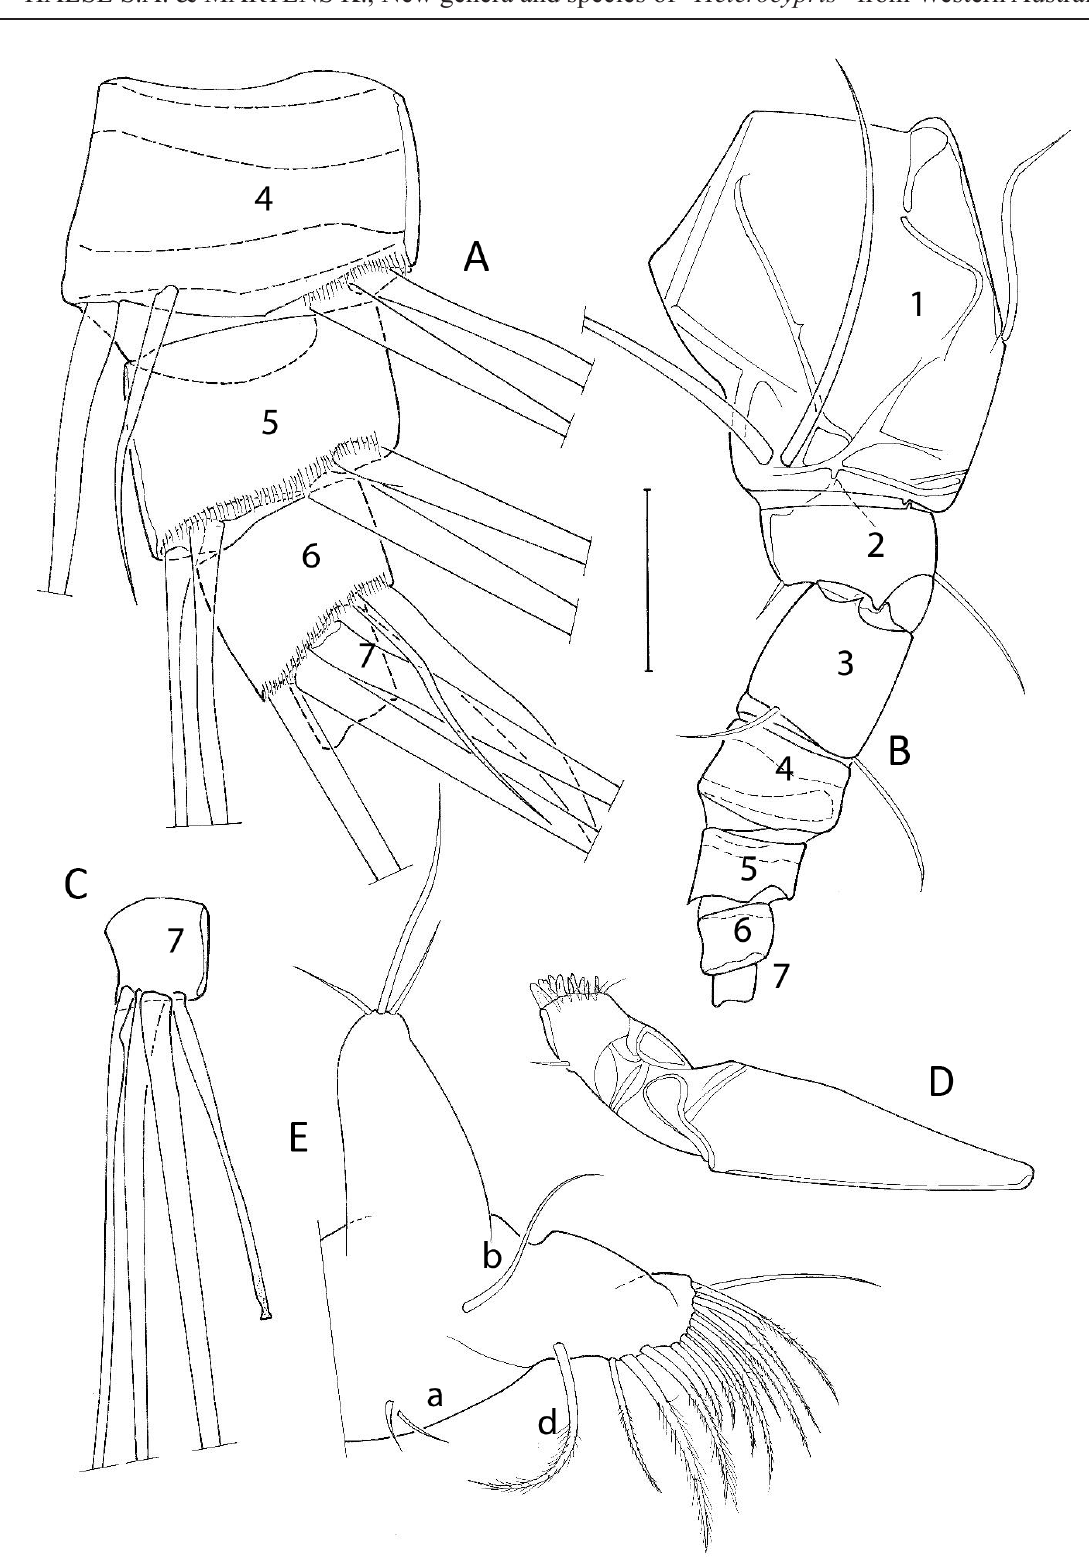
Fig. 3. Patcypris outback gen. et sp. nov., Lake Carey. A–C . ♂ (WAM 67197). A. A1, showing chaetotaxy of segments 4–6. B. A1, showing chaetotaxy of segments 1–3. C. A1, showing chaetotaxy of segment 7. D–E . ♀ (WAM 67198). D. Md coxa. E. T1 (respiratory plate not shown). Scale: A, C = 37 µm; B, E = 92 µm; D = 232